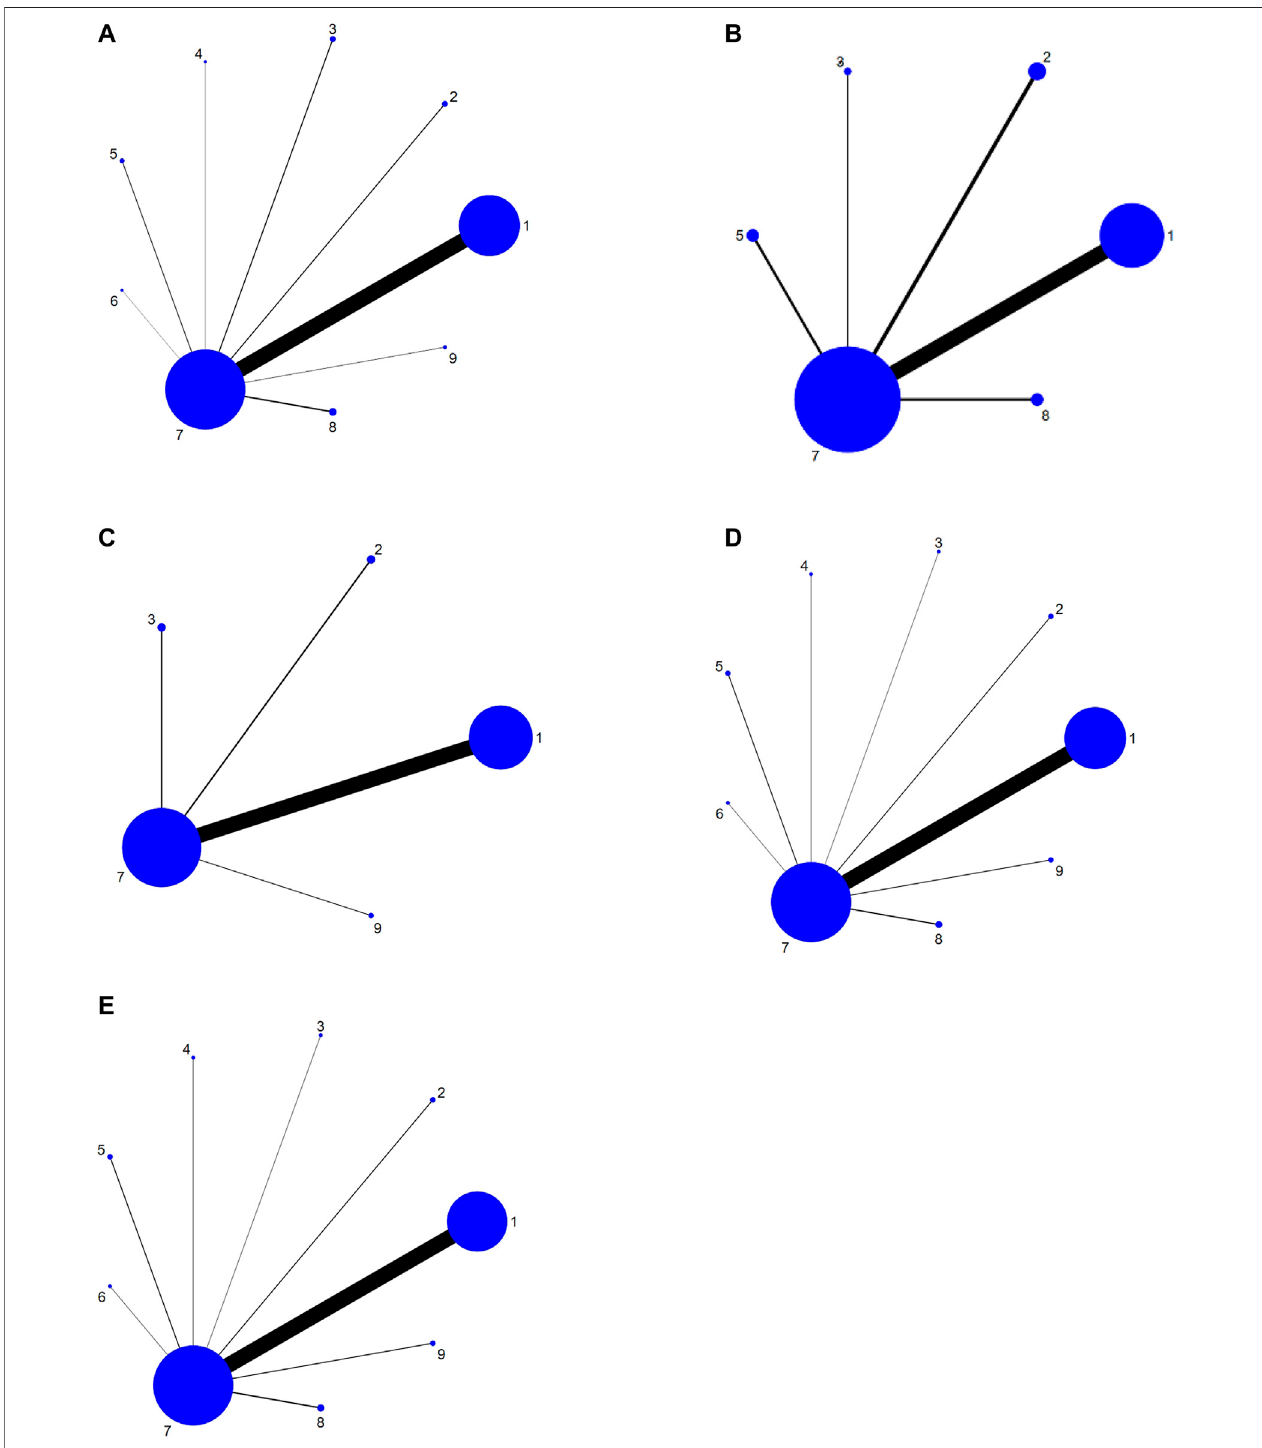
FIGURE 3 | Network graph for different outcomes. (A) Pain relief rate; (B) KPS; (C) Total Adverse Reactions; (D) Nausea and vomiting; (E) constipation. Note: 1, Fufangkusheninjection+analgesic;2,Huachansuinjection+analgesic;3,Aidiinjection+analgesic;4,Xiaoaipinginjection+analgesic;5,Kanglaiteinjection+analgesic; 6, Yadanziyouru injection + analgesic; 7, analgesic; 8, Fufangkushen injection; 9, Huachansu injection.